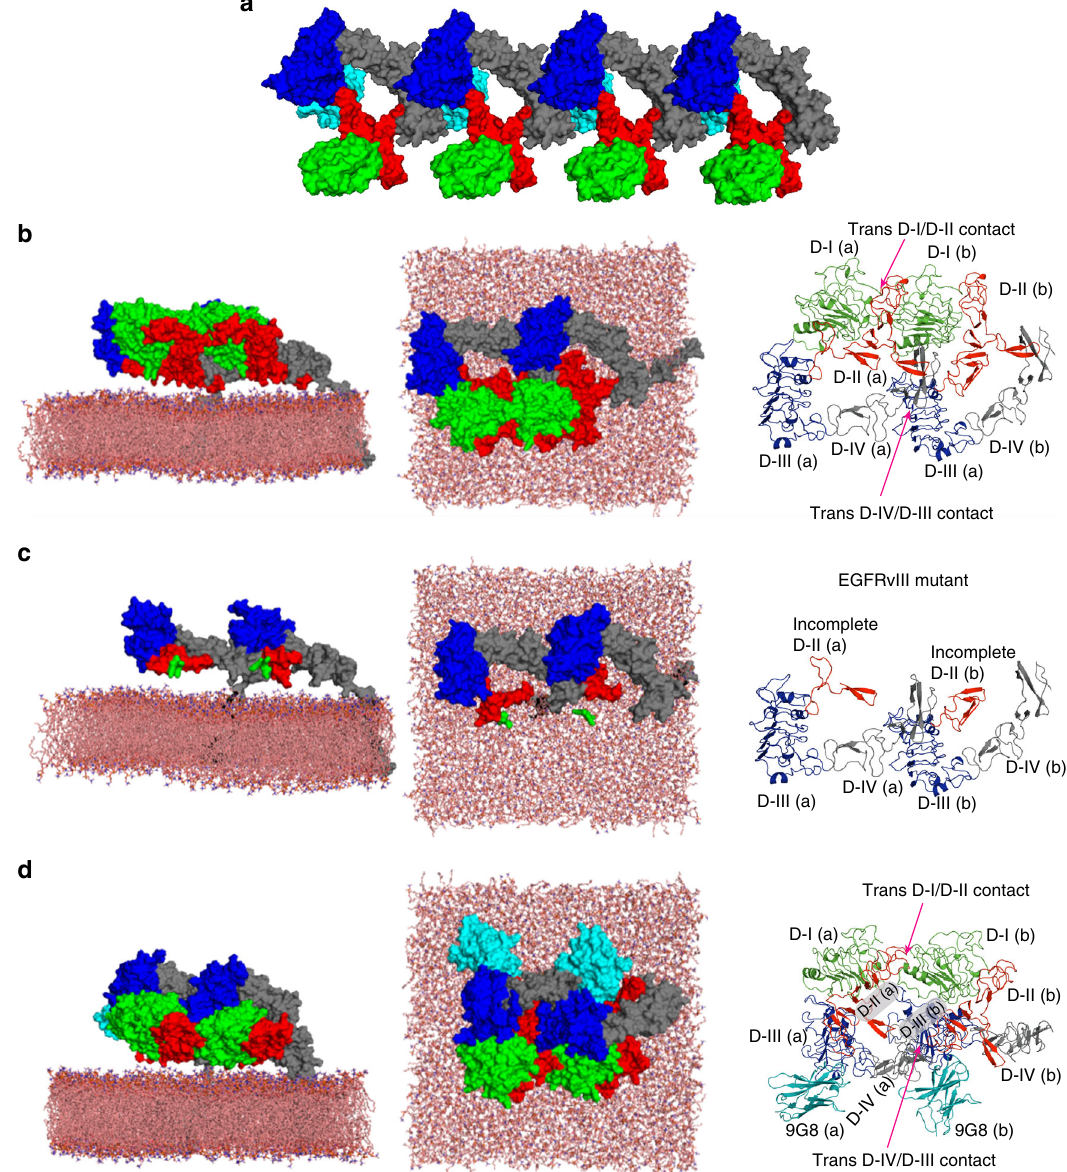
Fig. 3 The structural model of ligand-free head-to-head EGFR dimers. a An open-ended oligomer model of 9G8-bound EGFR extracellular domains in the inactive conformation built using the crystal contacts in the monomer structure in PDB ID 4KRP 42 , where 9G8-NB is coloured in cyan, EGFR DI in green, DII (red), DIII (blue), and DIV (grey). b A simulation-generated dimer structure of free EGFR extracellular domains and their TM domains in the lipid bilayer. The simulation was started from the crystal dimer of 9G8-bound EGFR extracellular domains in the tethered conformation in which the two copies of the 9G8-NB were removed from the simulation system. The images are based on the snapshot of the simulation at 20 µ s. One of the two transmembrane helices is visible (left and middle panels). The right panel shows the dimer viewed from the membrane, where the trans interaction between DI and DII and the interaction between DIV and DIII are highlighted; the domains of monomer a and b are labelled. c By deleting residues 6 – 273 from the dimer structure in b , the dimer structure directly mapped to the EGFRvIII glioblastoma mutant. As shown, this dimer structure is likely not viable in EGFRvIII as the trans interaction between DI and DII is precluded by the deletion. d A simulation-generated dimer structure of 9G8-bound EGFR extracellular domains starting from a crystal dimer of 9G8-bound EGFR extracellular domains in the tethered conformation. These images are based on the snapshot of the simulation at 20 µ s. Invisible from this image are the TM helices embedded in the membrane. The right panel shows the 9G8-bound dimer viewed from the membrane, where the trans-dimer interaction between DI and DII, and between DIV and DIII are